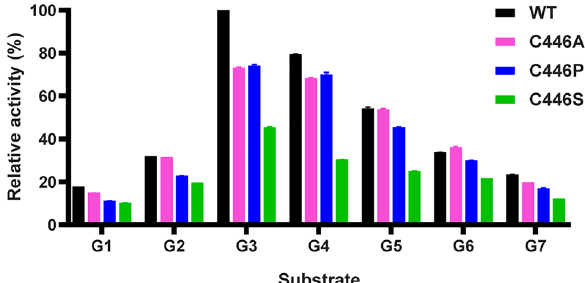
Figure 5. Substrate specificity of WT and C446 mutated Sa AMs in disproportionation reaction using malto- oligosaccharides (maltose, G2 to maltoheptaose, G7) as substrate. The activity of WT- Sa AM on G3 substrate was set as 100%. *P < 0.05 (Student’s t-Test with respect to the disproportionation of WT). Data are presented as the mean ± SD and are derived from three independent experiments.